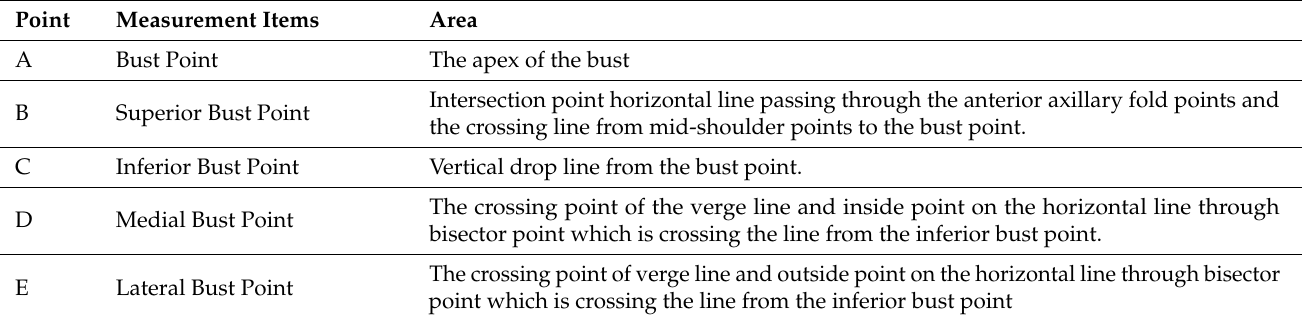
Table 3. Measurement method of breast details.